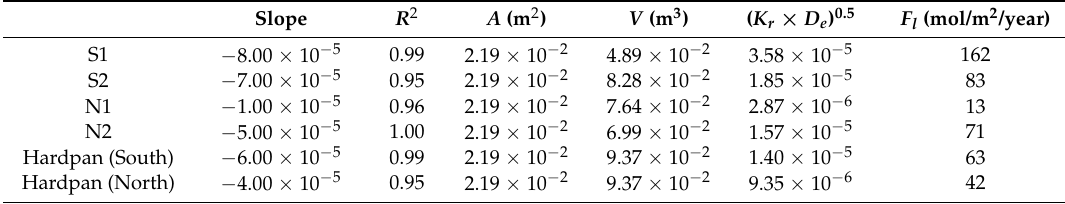
Table 2. Results of in situ oxygen consumption tests on oxidized and hardpan